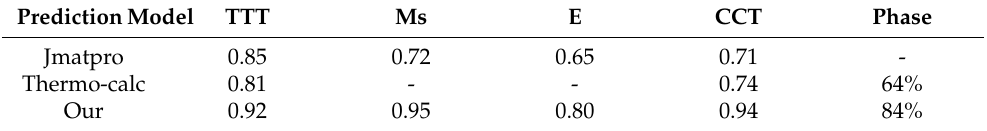
Table 3. Accuracy comparison between the proposed framework and the simulation software. Prediction